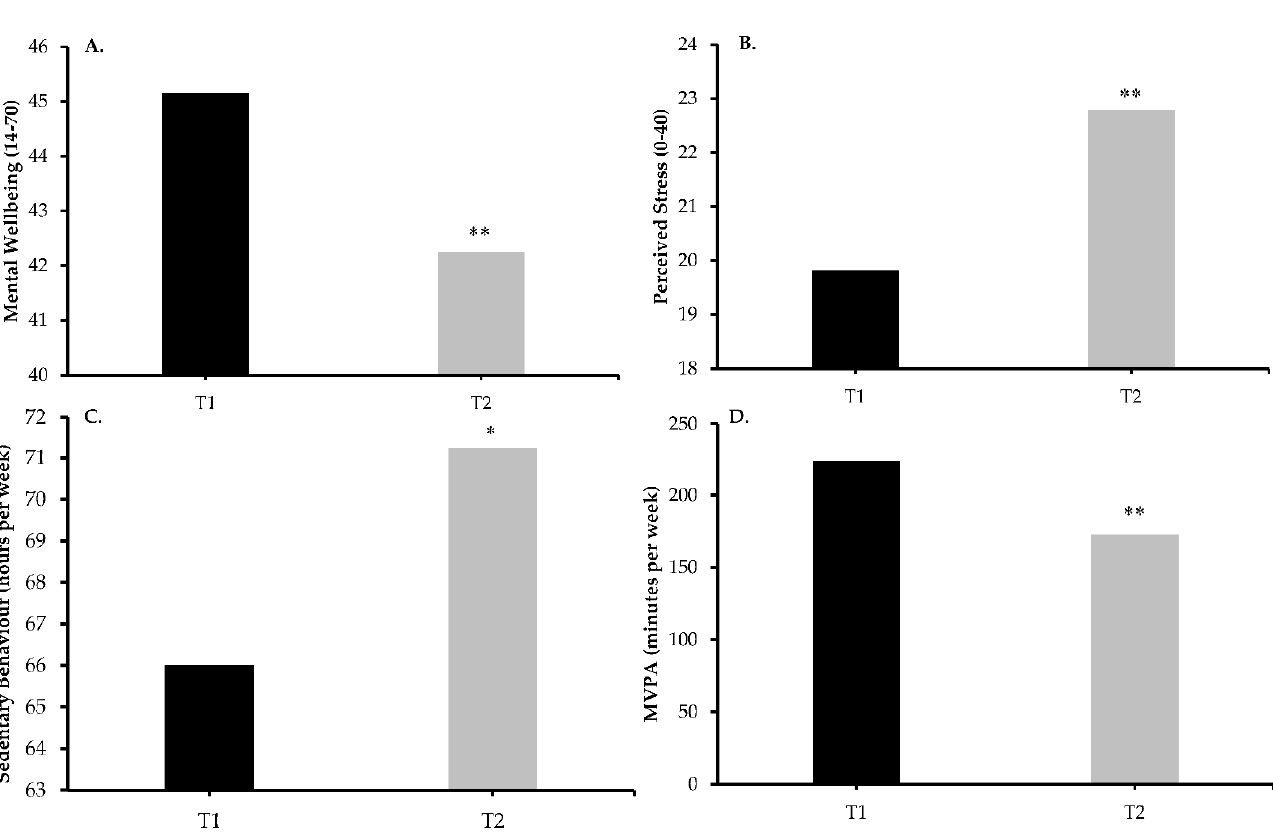
Figure 2. Changes in variables over time. ( A ) Mental wellbeing was lower at T2 compared to T1; ( B ) Perceived stress was greater at T2 compared to T1; ( C ) Sedentary behaviour was greater at T2 compared to T1; ( D ) MVPA was lower at T2 compared to T1. ** indicates p < 0.001; * indicates p < 0.05.